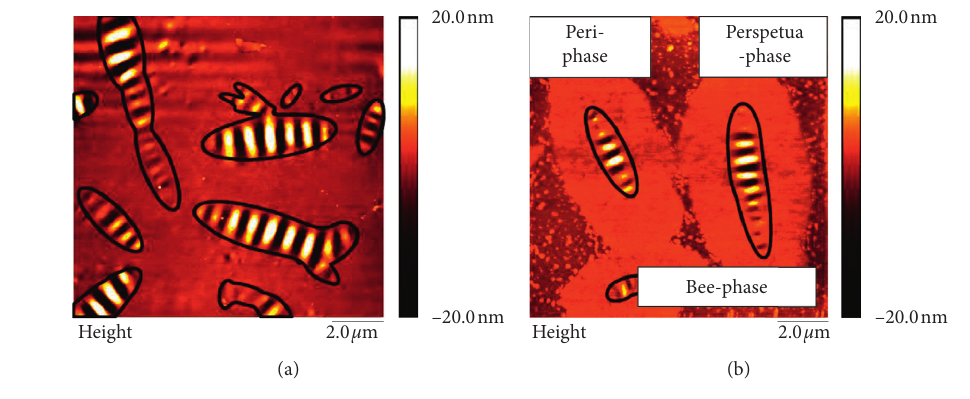
Figure 6: Bee structure. (a) MRMA and (b) MA. Table 6: Matrix statistical table of the area of the bee-like